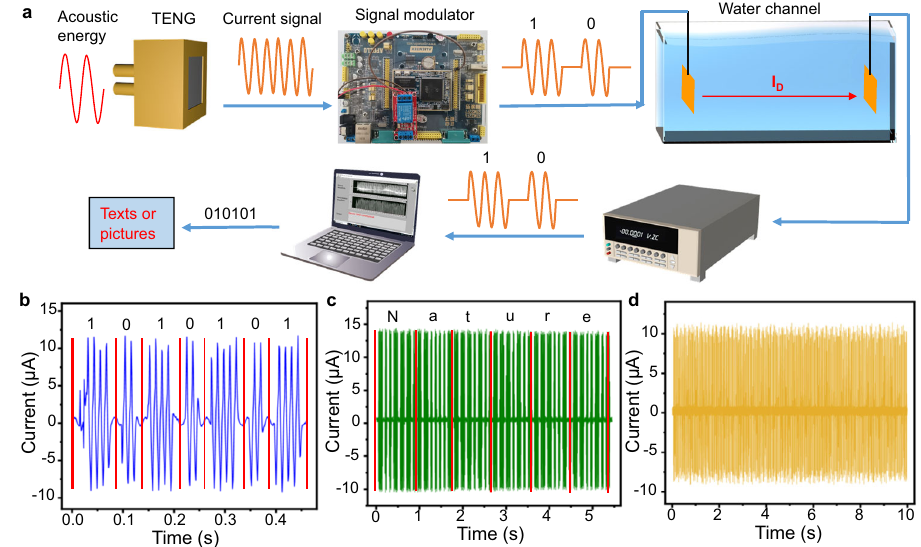
Fig. 5 The modulation and demodulation of current signals for data transmission in water. a Schematic diagram of the modulation and demodulation process. b The modulated digital signals transmitted in water. c The demodulated current signals to a word after transmitting in water. d Part of current signals transmitted for an